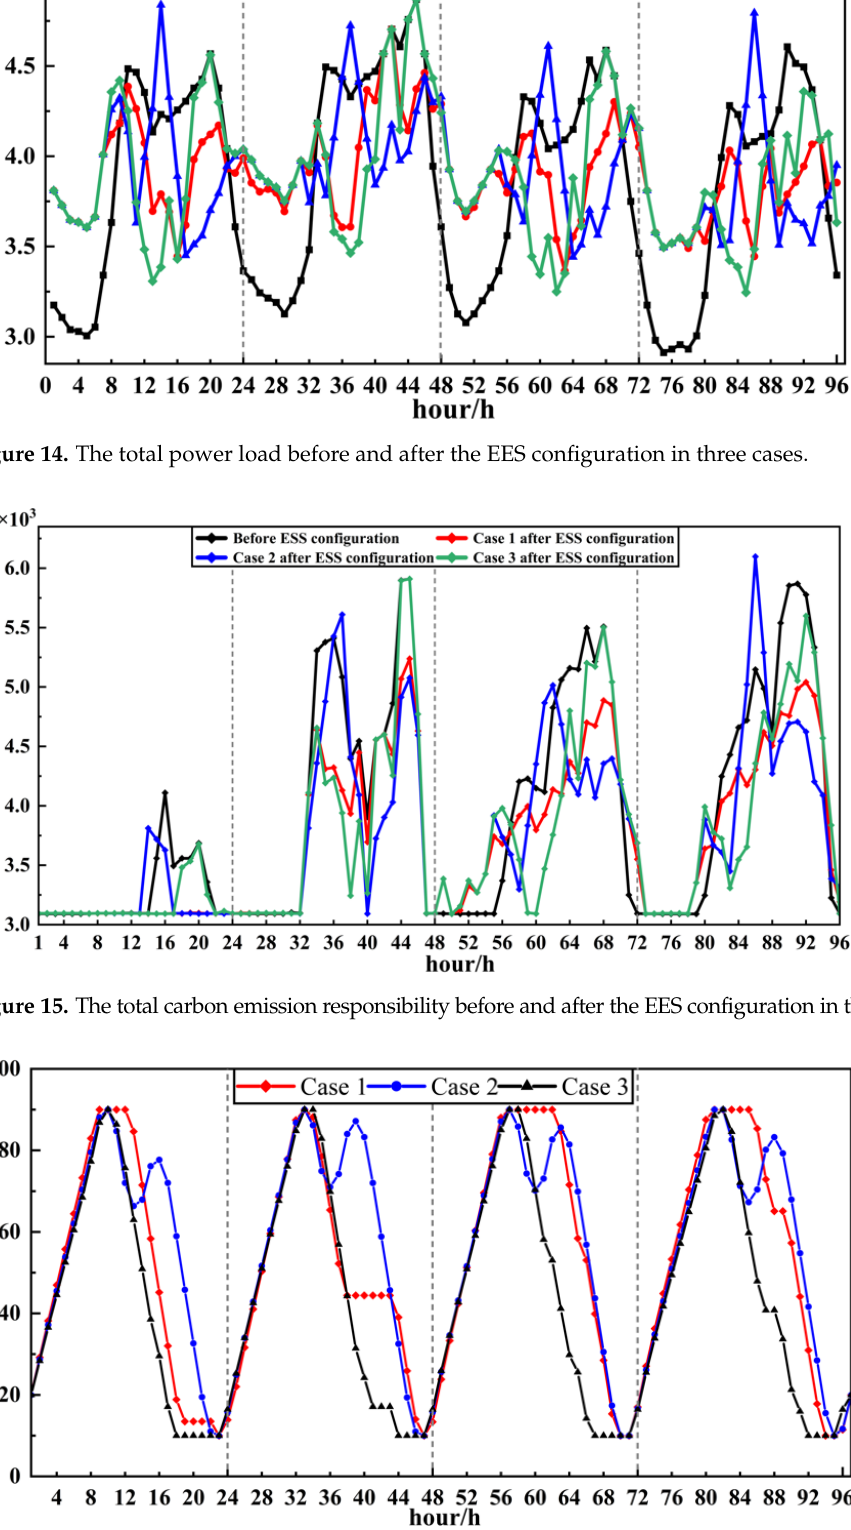
Figure 16. The SOC of the EES at Bus 3 in three cases.